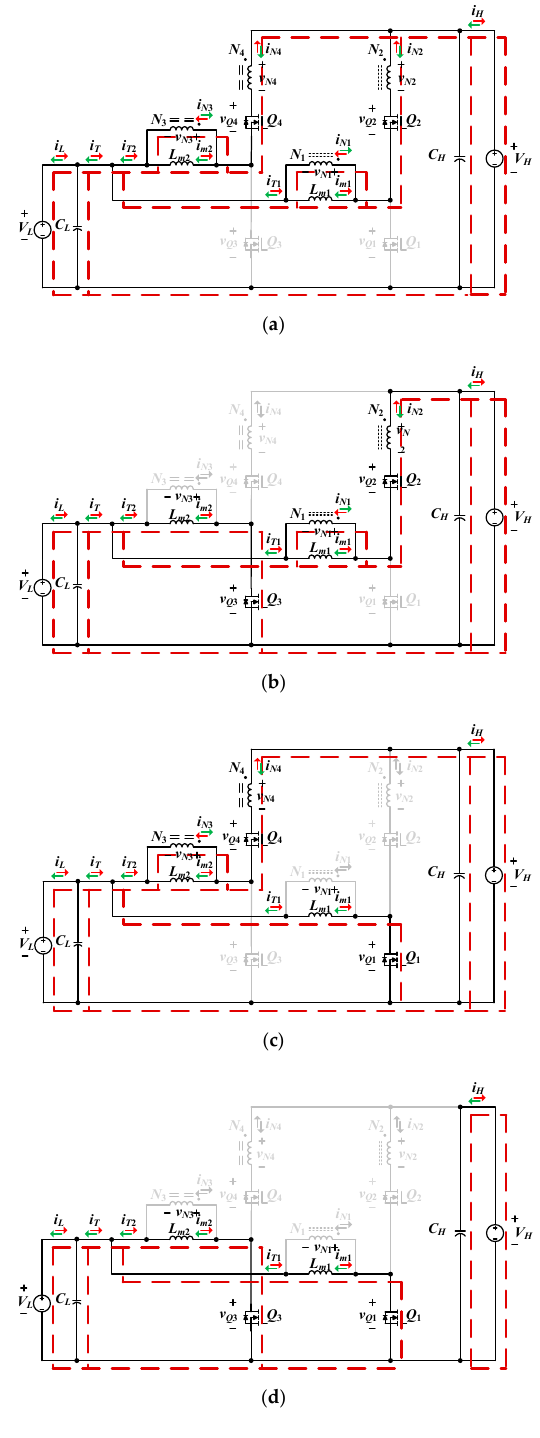
Figure 5. Equivalent circuits of the proposed converter. ( a ) State 1: Q 2 , Q 4 on, and Q 1 , Q 3 off. ( b ) State 2: Q 2 , Q 3 on, and Q 1 , Q 4 off. ( c ) State 3: Q 1 , Q 4 on, and Q 2 , Q 3 off. ( d ) State 4: Q 1 , Q 3 on, and Q 2 , Q 4 off. (The arrows in green indicate the charge mode, and the arrows in red indicate the discharge mode.).